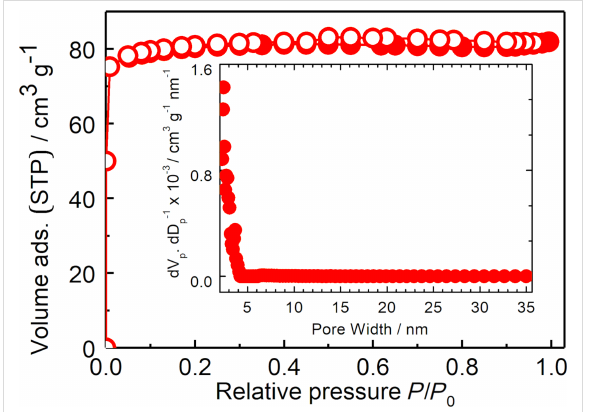
Figure 4: Nitrogen adsorption (solid circles) and desorption (open circles) isotherms of the as-synthesized Na,K-ETS-10. The inset shows the calculated pore width distribution according to the NLDFT.